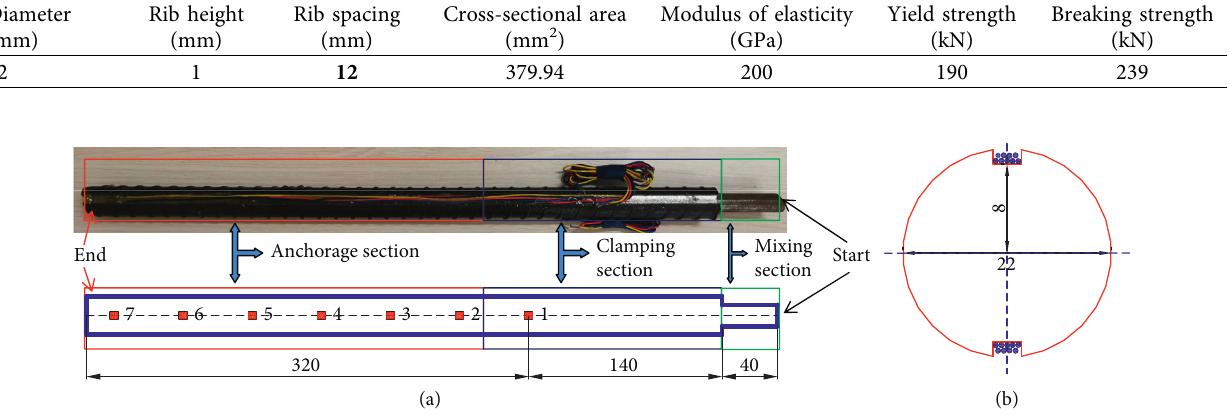
Figure 1: Strain gauge layout of force measuring bolt (unit: